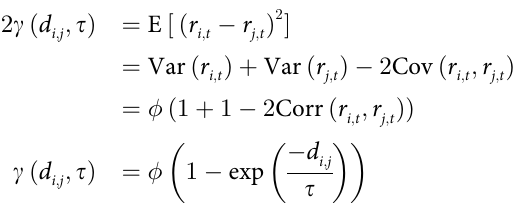
Table 1. Differences between standard GEE found in longitudinal studies and the proposed GEE. Standard GEE Proposed GEE Clusters Individuals/Patients Time points (Dates) Repeated Measures Repeated at different time points Repeated at different locations Working Correlation Independent, Exchangeable, AR, etc. Semivariogram model